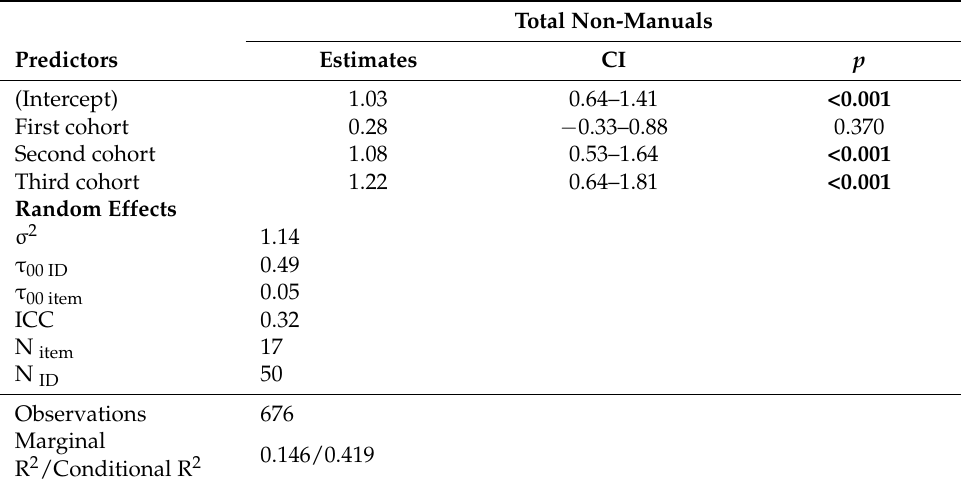
Table 4. Table of fixed and random effects predicting total non-manual production. Table gener- ated using the tab_model function from the SJPlot package version 2.6.2 for the R programming environment (Lüdecke